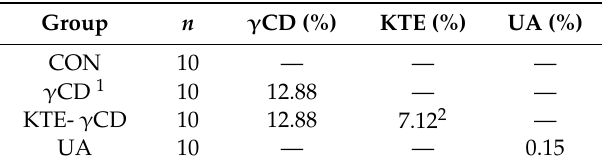
Table 1. Experimental